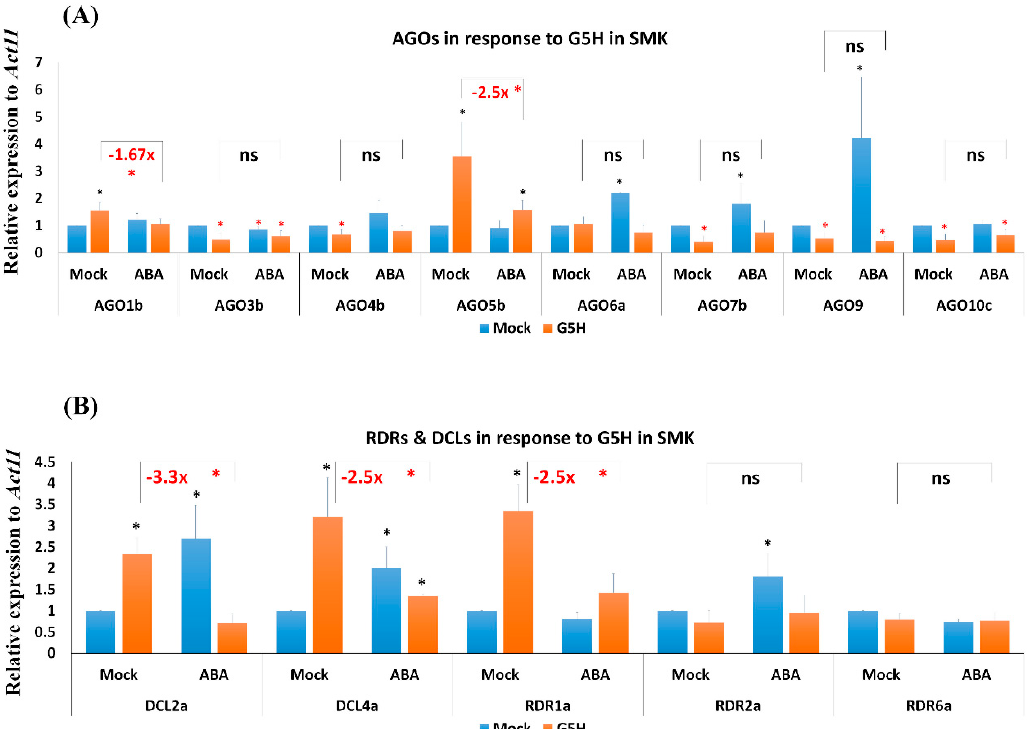
Figure 6. Expression levels of RNA-silencing genes in SMK plants infected with G5H. Expression levels of AGO genes ( A ), and DCL and RDR genes ( B ) in SMK soybean cultivar ( rsv3 -null) in response to G5H infection, ABA treatment, or both. Plants were collected 5 dpi for RNA extraction and RT-qPCR. Data are means ± standard deviation from three biological replicates. Statistical analysis was carried out for each gene using Student t -test; the means for plants treated with ABA alone, G5H alone, or the combination of ABA and G5H were individually compared with the mean for plants that were not treated with ABA or G5H: * and * indicate a significant increase or decrease, respectively, at P < 0.05. Additional analyses were carried for ABA-G5H in comparison with Mock-G5H where ns and * indicate non-significance and significance at P < 0.05, respectively.